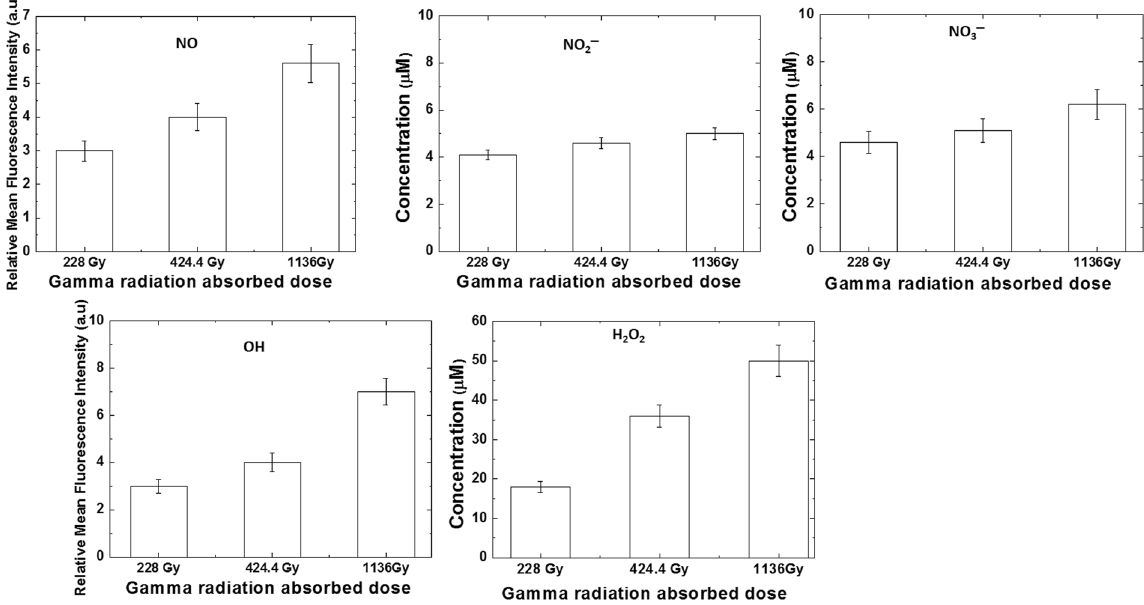
Figure 5. Analysis of reactive oxygen and nitrogen species detection in phosphate buffer after treatment with different gamma rays absorbed dose such as 1136, 424 and 228